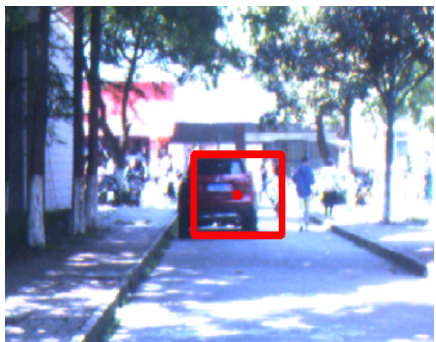
Figure 8. Initial radar region of interest.